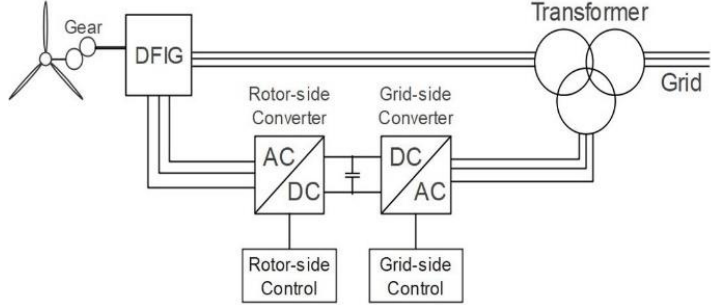
Figure 2. Grid-connected DFIG-based WECS.